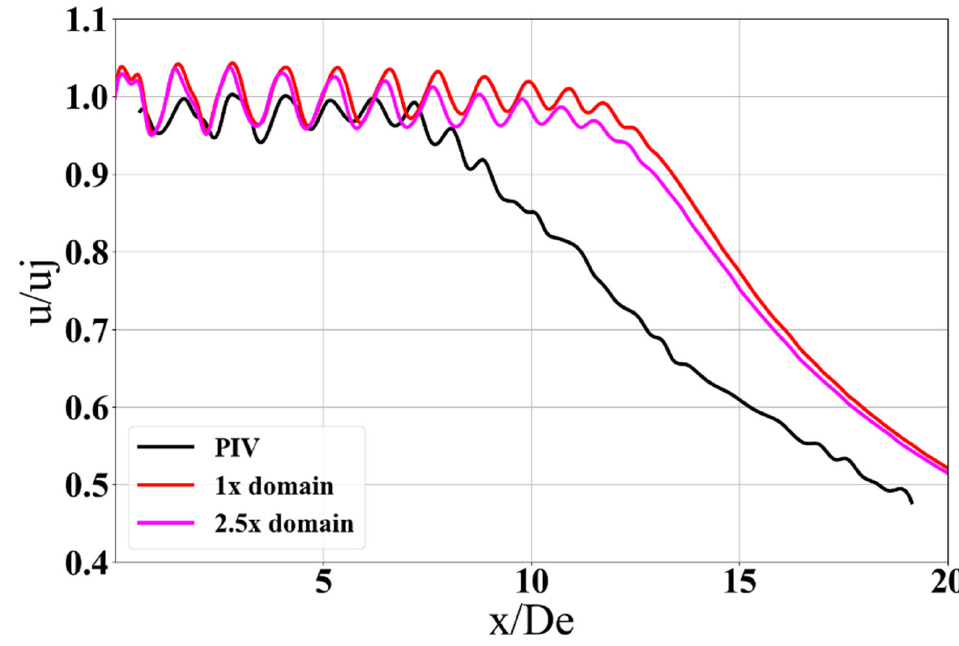
Figure 5. Domain dependency study compared with PIV data from [60].